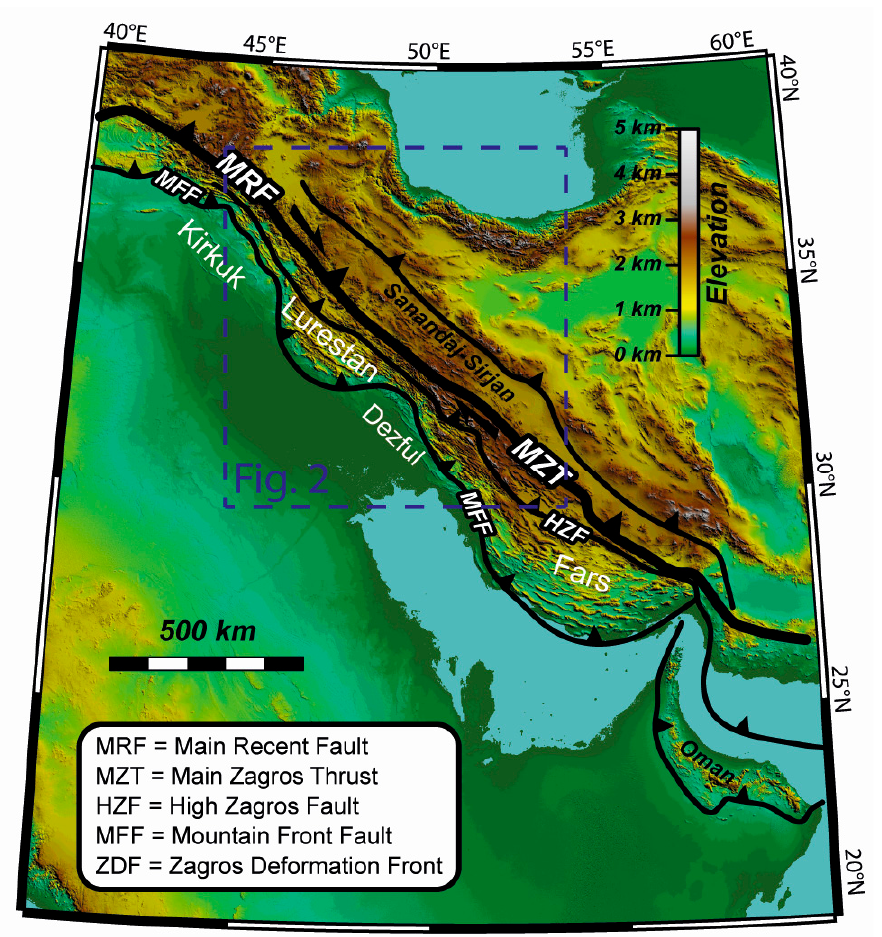
Figure 1. Tectonic sketch map of the Zagros Mts.